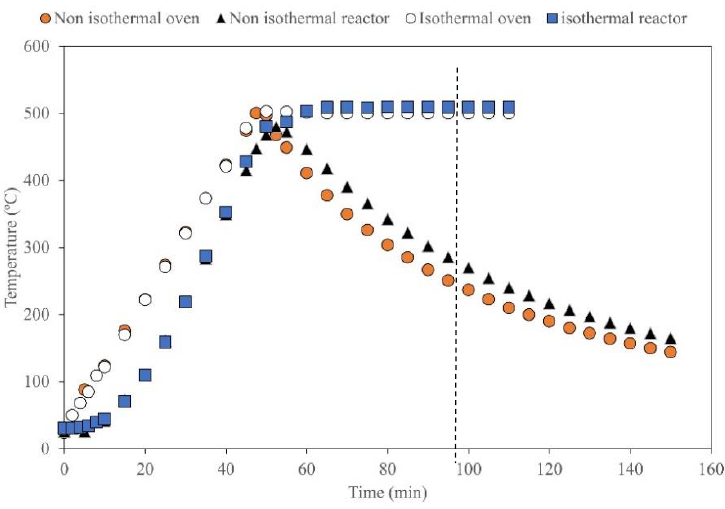
Figure 2. Temperature profiles in the oven (circles) and inside the reactor, in both isothermal and non-isothermal cases. The samples were introduced when the oven temperature reached 500 °C (vertical dashed-line).